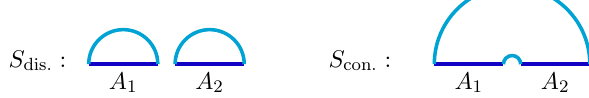
Fig. 1 Schematic representation of two different configurations for computing S ( A 1 ∪ A 2 ) . In the case of a disconnected diagram S ( A 1 ∪ A 2 ) = 2 S ((cid:3)) , whereas for a connected diagram S ( A 1 ∪ A 2 ) = S ( 2 (cid:3) + h ) + S ( h